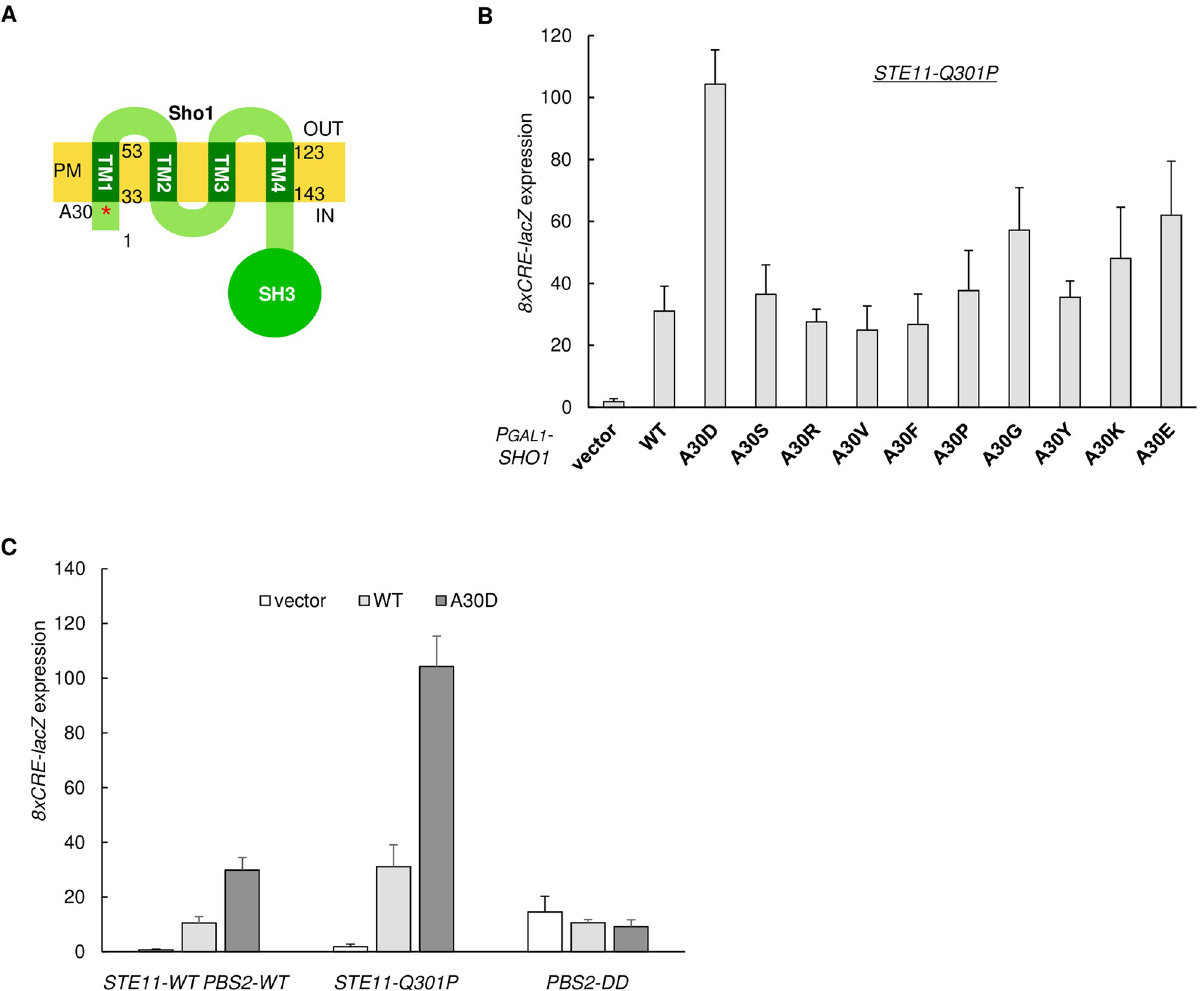
Fig 3. Isolation of the hyperactive Sho1-TM mutant, in which activation of Pbs2 by Ste11 is enhanced. ( A ) Diagram of the four TM domains in Sho1. Numbers indicate amino acid positions. Asterisk indicates the position of Ala-30. ( B, C ) Expression of the Hog1-specific reporter gene 8xCRE- lacZ . β -galactosidase activity is expressed in Miller units. Error bars represent S.D. (n � 3). (B) The yeast strain KT024 ( ssk2/22 Δ sho1 Δ STE11-Q301P ) was transformed with a reporter plasmid carrying the 8xCRE-lacZ gene and a plasmid that expresses the indicated Sho1 mutants from the GAL1 promoter (P ). Expressions of Sho1 mutants were induced by 2% galactose for 2 hr, and expression of the 8xCRE-lacZ gene was determined. (C) The GAL1 yeast strain KT039 ( ssk2/22 Δ sho1 Δ pbs2 Δ ) was transformed with a single copy plasmid that expressed either Pbs2-WT or Pbs2-S514D T518D mutant from its native promoter in addition to the 8xCRE-lacZ reporter plasmid and another plasmid that expresses Sho1-WT, Sho1-A30D, or none (vector) from the GAL1 promoter (for PBS2-WT , or PBS2-DD ).